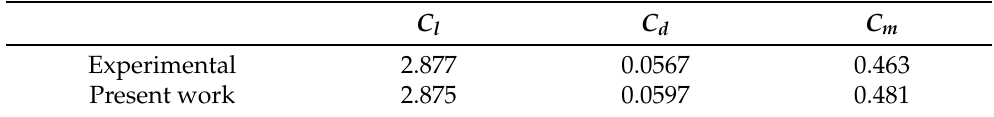
Table 1. Comparison of numerical and experimental lift and drag aerodynamic coefficients and pitching moment coefficient of the NLR 7301 airfoil with trailing-edge flap.